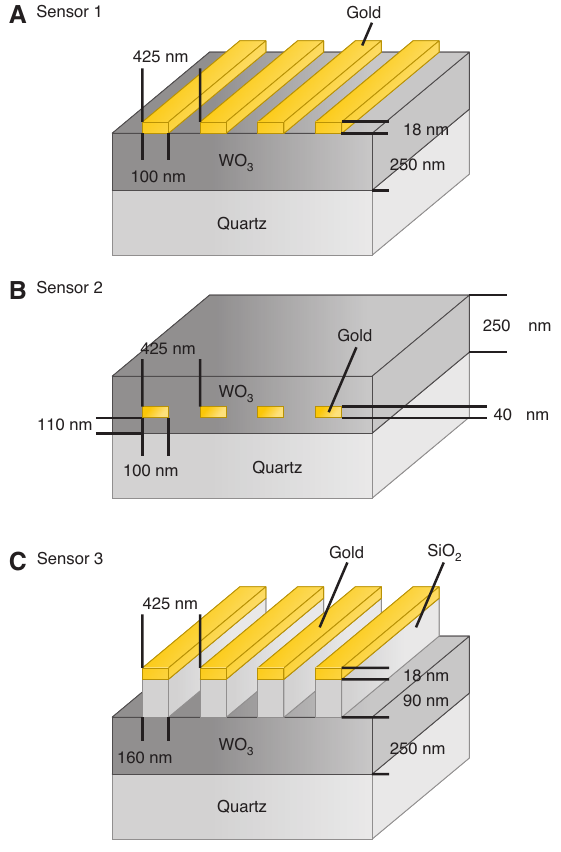
Figure 5: Three different sensor designs. Hydrogen sensor design with (A) the gold wires directly on top of the 250-nm-thick WO waveguide, (B) the gold wires embedded within 3 the 250-nm-thick WO waveguide, and (C) the gold wires separated 3 from the 250-nm-thick WO waveguide by introducing SiO 3 spacer